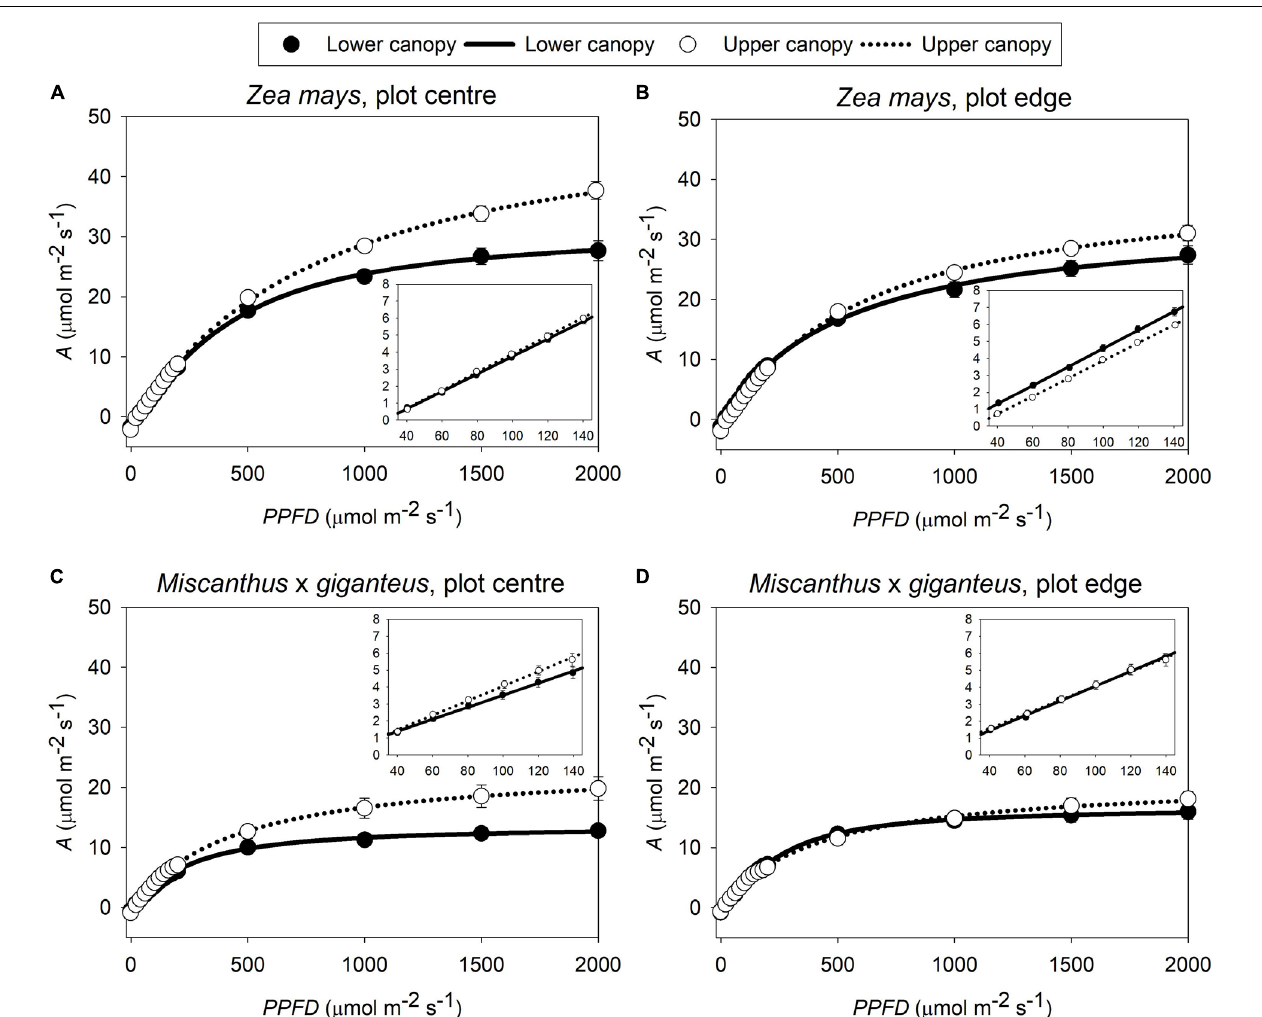
FIGURE 1 | Average response curves of A to PPFD in both canopy positions (upper, lower) of (A) Z. mays in plot centre and (B) plot edge; and (C) M. x giganteus in plot centre and (D) plot edge ( n = 8–16). Symbols give the mean A ± s.e. at each level of PPFD . Lines give the non-rectangular hyperbolae fit to these measurements. In each panel, the inset shows the light-limited section of the response curve ( PPFD from 40 to 140 µ mol m − 2 s − 1 ), used to estimate maximum quantum yields by linear regression: the slope of this regression gives the trait φ CO 2 max , app .